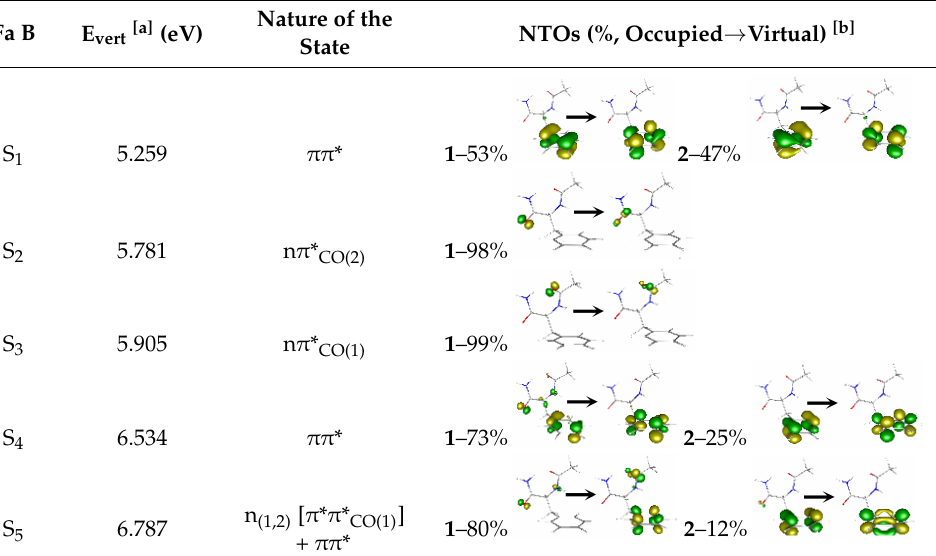
Table 1. Nature and CC2/cc-pVDZ vertical excitation energies of the five lowest excited states of Fa B at the B97-D2/TZVPP optimized geometry of the ground